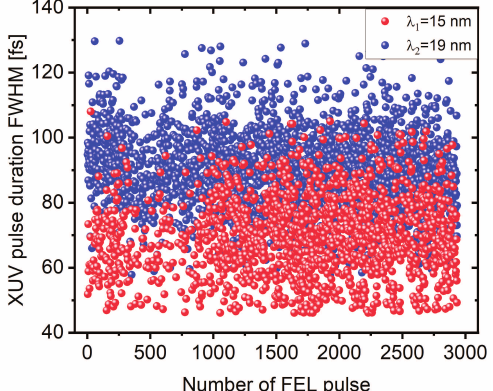
Figure 10. Measured pulse duration for 3000 FEL pulses. The shorter wavelength λ 1 = 15 nm (red) shows a shorter pulse duration on average of 70 fs FWHM, while the pulse duration of λ 2 = 19 nm (blue) is 90 fs